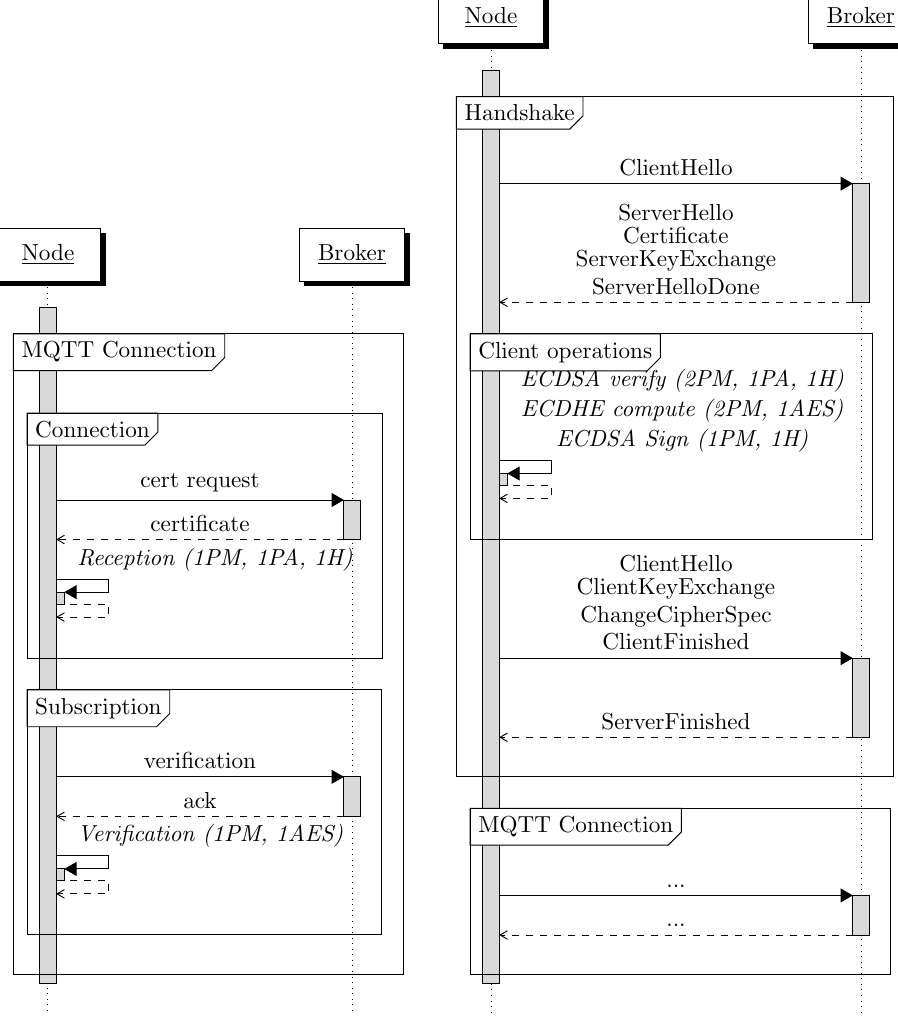
Figure 7. Comparison of the computational overhead of our security scheme compared to a TLS 1.2 handshake based on